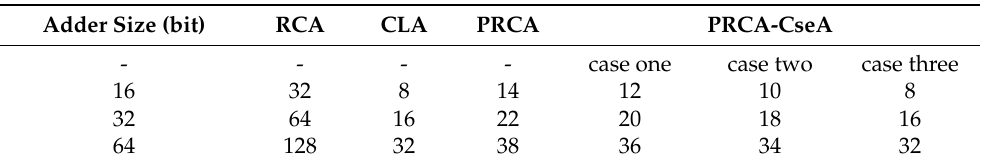
Table 3. Latency in terms of gate count for conventional RCA, CLA, proposed PRCA, and our PRCA-CSeA